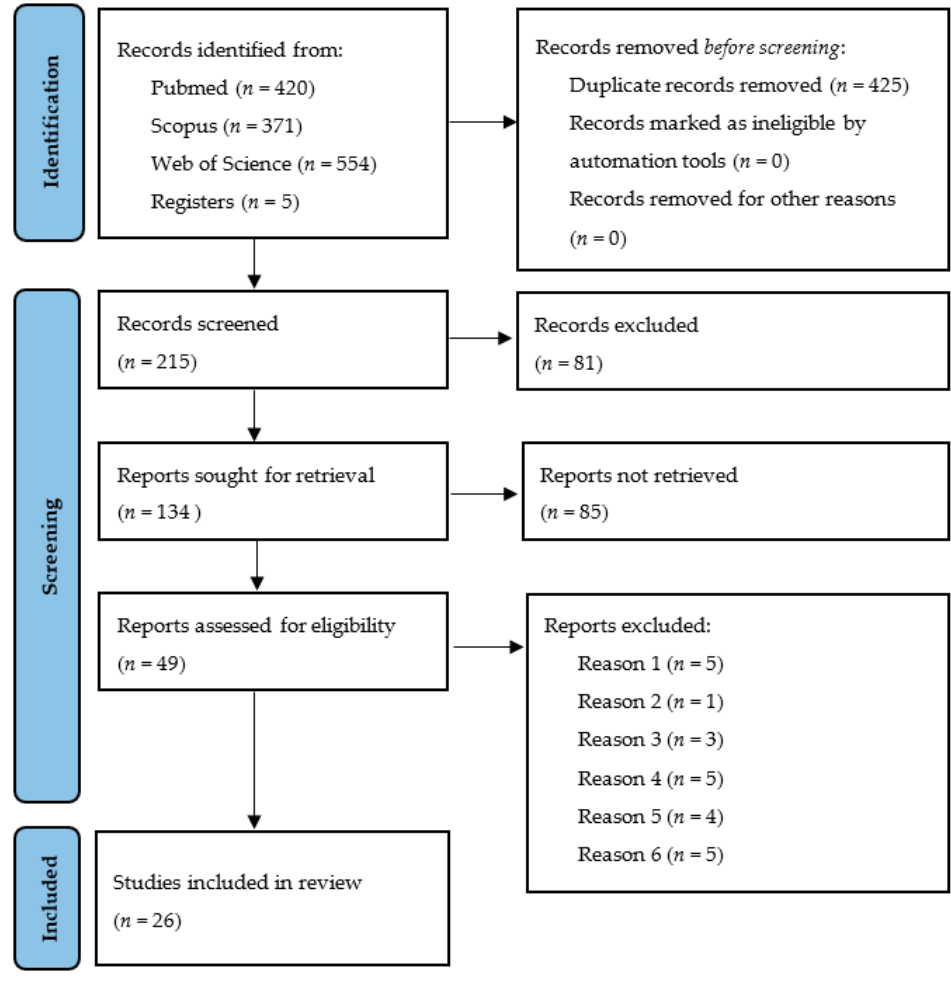
Figure 1. PRISMA flow chart diagram. Table 1. Search strategy according to the focused question